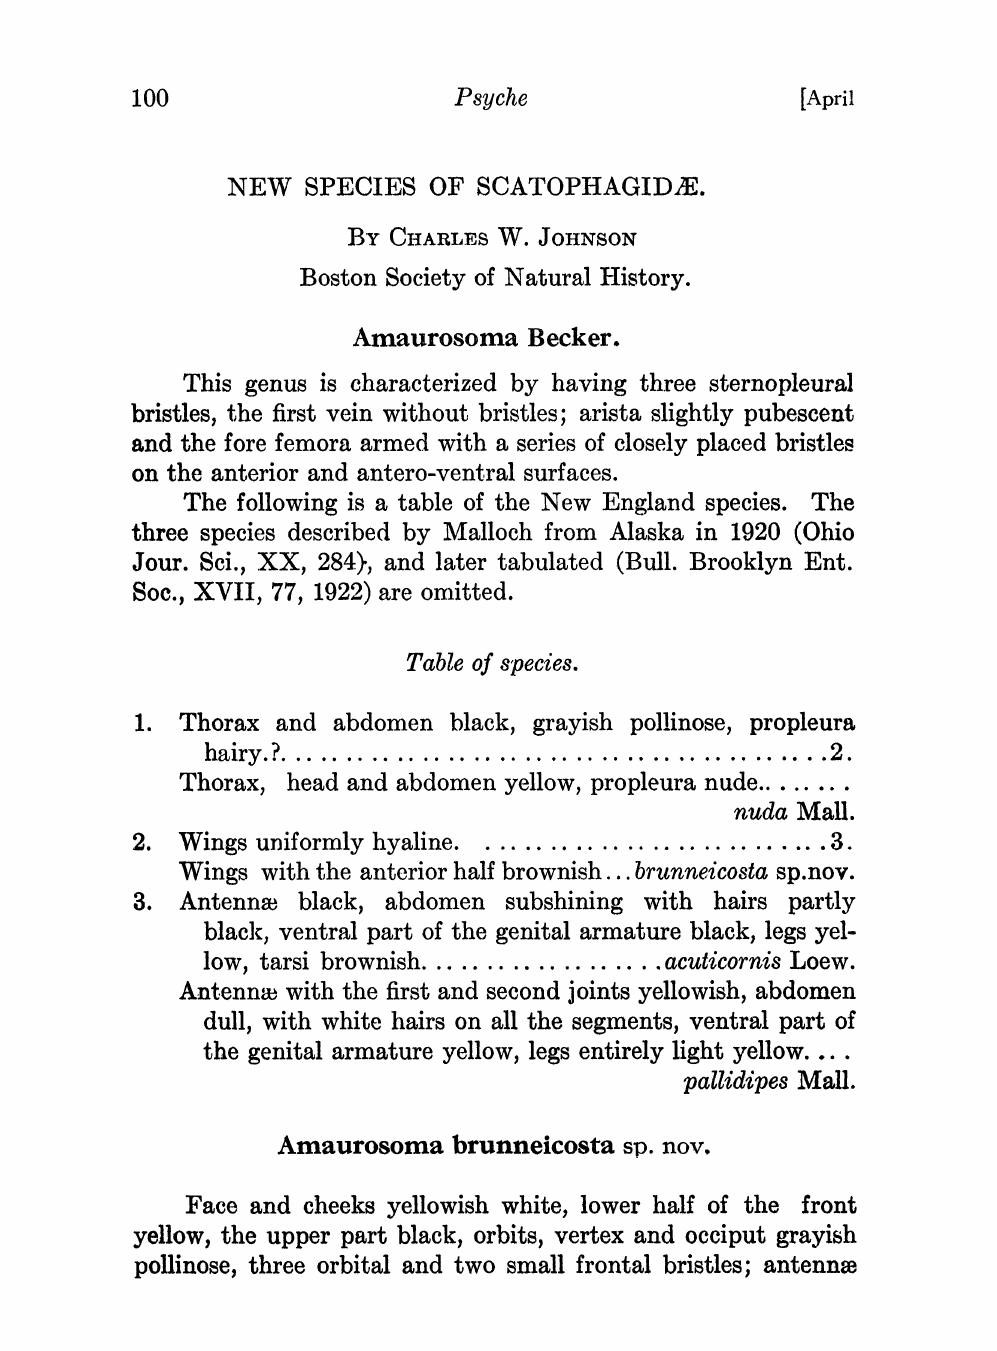
acuticornis Loew.